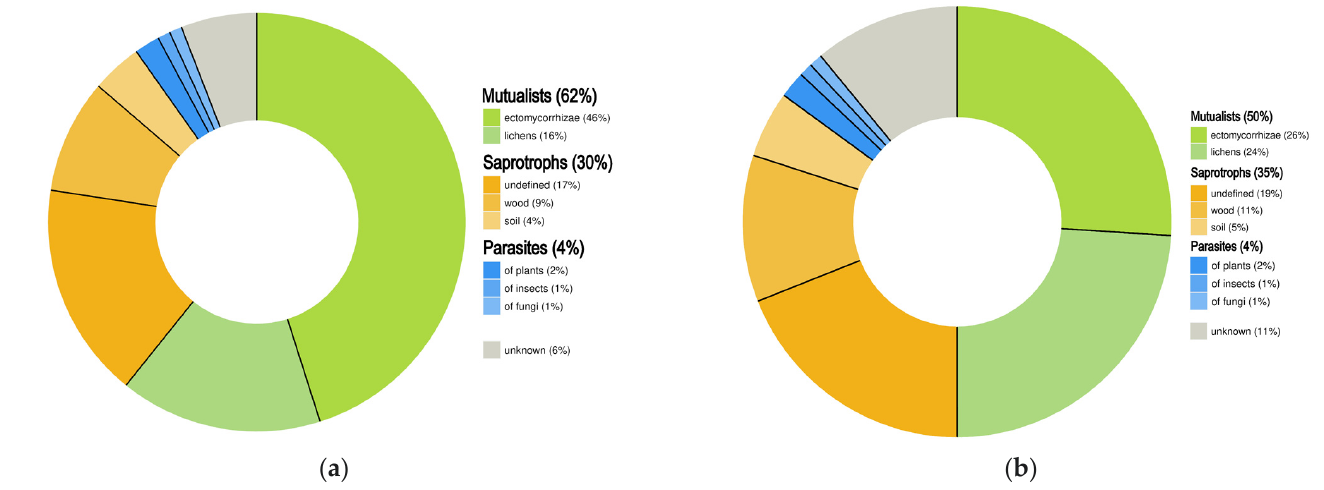
Figure 6. Proportion of different trophic guilds for ( a ) all assessed fungi (n = 597) and ( b ) threatened species in the July 2022 Red List update (n = 284).